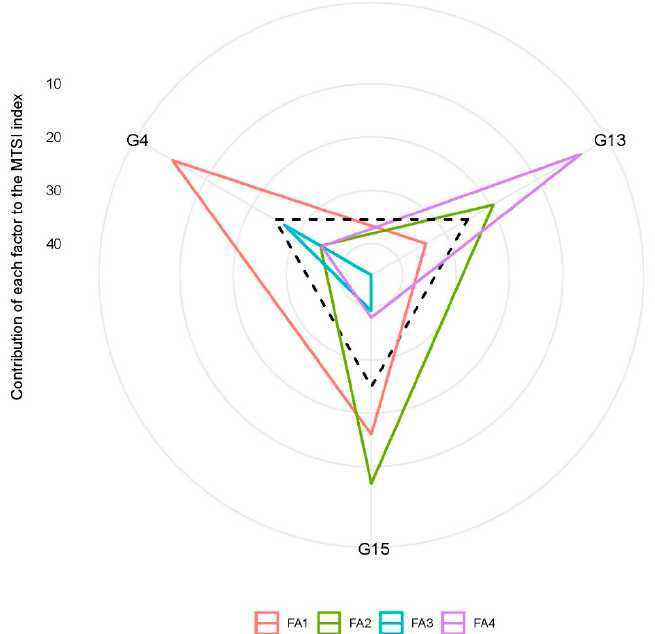
Figure 7. Strengths and weaknesses view of the stable landraces identified across environments, shown as the proportion of each factor on the computed MTSI. Smaller proportions explained by a factor (closer to the external edge) indicate that the trait within that factor is more similar to the ideotype. The dashed line represents the value that would be expected if all factors contributed equally. FA1: BRN, NIP, NFI, and PNP; FA2: SY, HI, HSW, and BL; FA3: AGB and Height; and FA4: PL, SNP, and NAOP. 10, 20, 30 and 40 indicate the contribution of each factor to the MTSI.